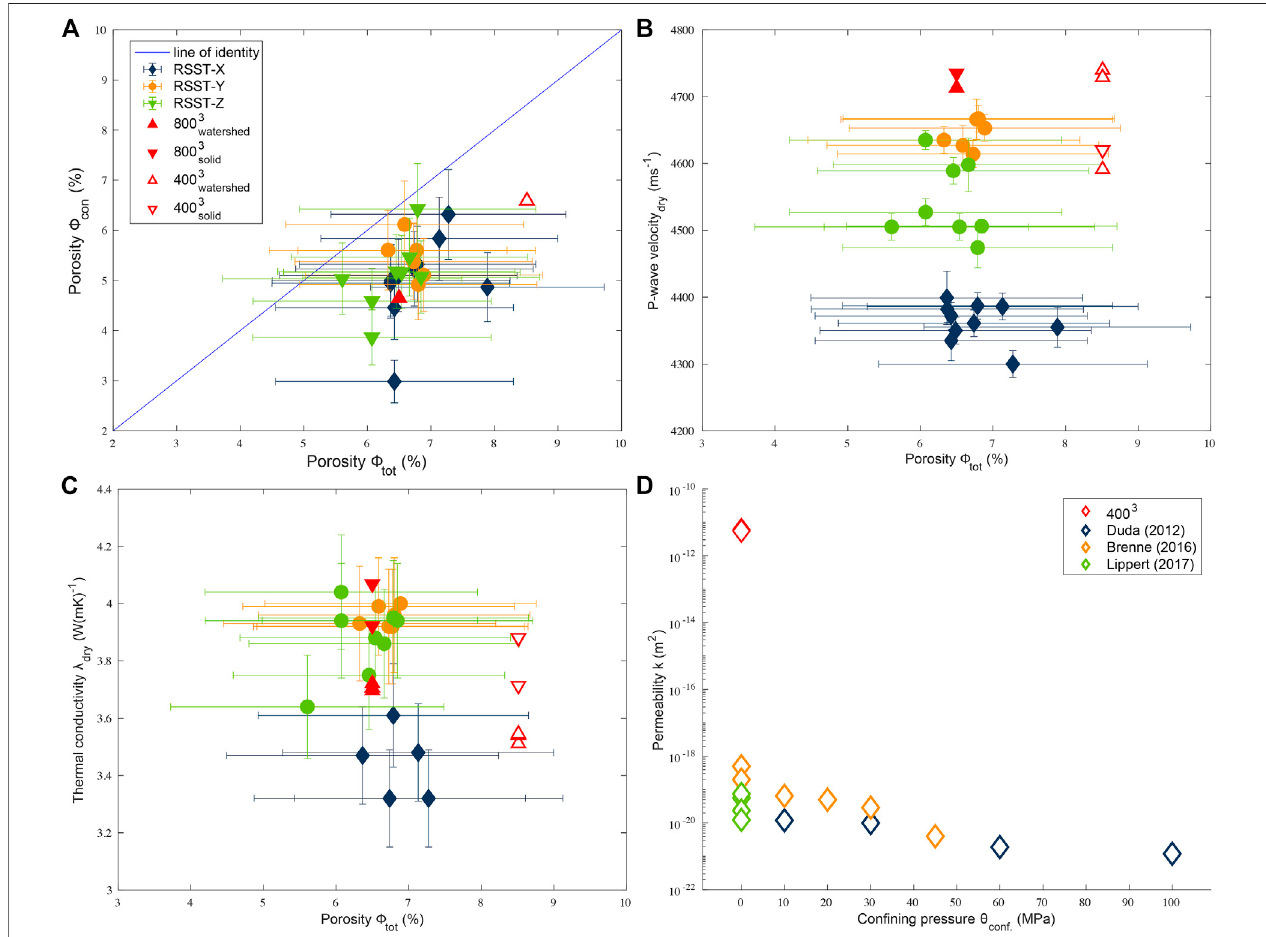
FIGURE 3 | Correlation between (A) connected and total porosity, (B) P-wave velocity and total porosity, (C) thermal conductivity and total porosity, and between (D) permeability and con fi ning pressure [see permeability measurements in Duda (2012), Brenne (2016), Lippert (2017)]. Filling and coloring of markers indicate sample andsampledirection,respectively.Measurementuncertaintiesareindicatedbyerrorbars.Whereerrorbarsdonotexceedmarkersize,uncertaintiesappeartobesmall. The bluelineinpanel (A) indicates identity, i.e.,connectedporosity correspondsexactlytototalporosity.Filledand un fi lledred trianglesindicatedifferentnumerical approachesfor800 3 and400 3 voxelsubvolumes,respectively.Measurementsinpanel (A – C) wereconductedatambientconditions.Laboratorymeasurementsinpanel (D) have not been determined in the scope of this study and can be looked up for detailed information in Duda (2012), Brenne (2016), Lippert (2017). The abbreviations RSST and e.g., X indicate the rock sample Ruhr sandstone and the drilled direction from the parent cube, respectively.